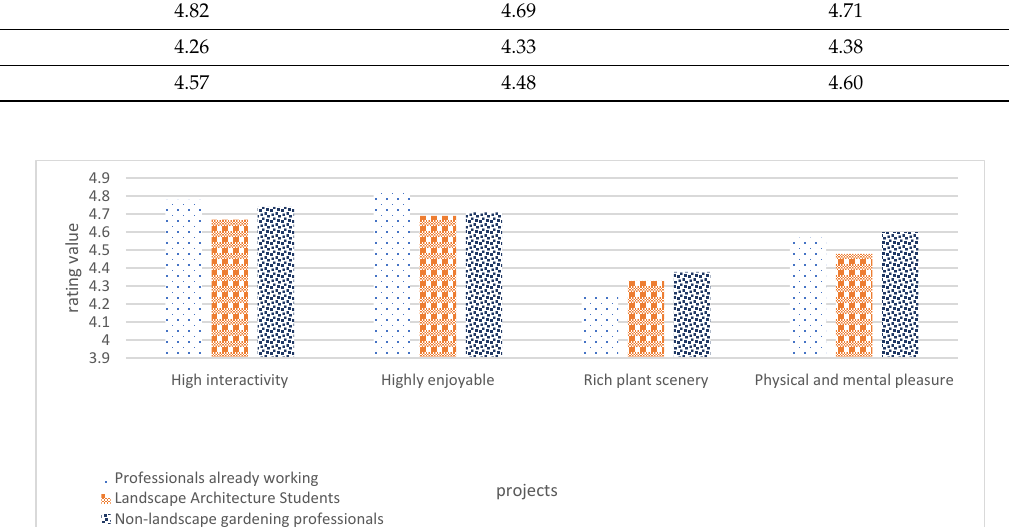
Table 3. Respondents’ evaluation of the effectiveness of computer vision -based MID .